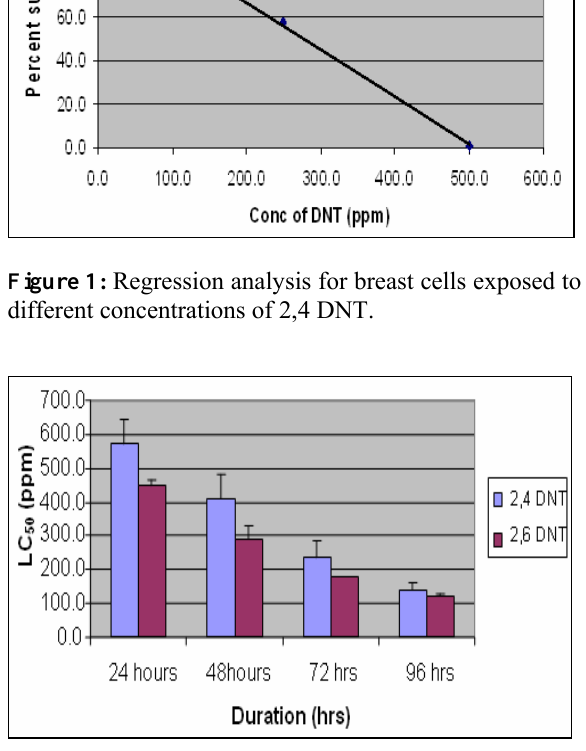
Figure 2: LC values of 2,4 and 2,6 DNT for breast 50 cells exposed at various times.